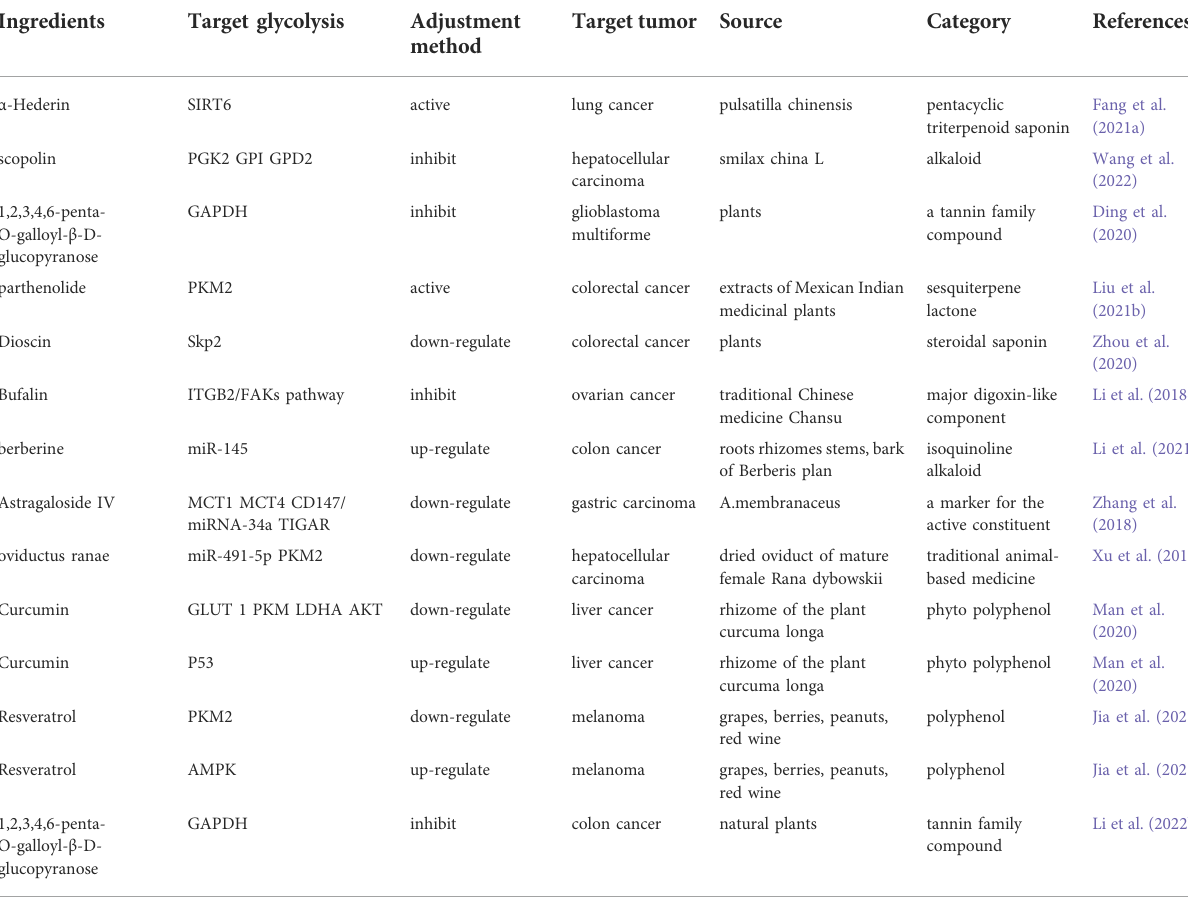
TABLE 5 Natural products regulate glycolysis through the lasted signal pathway in cancer